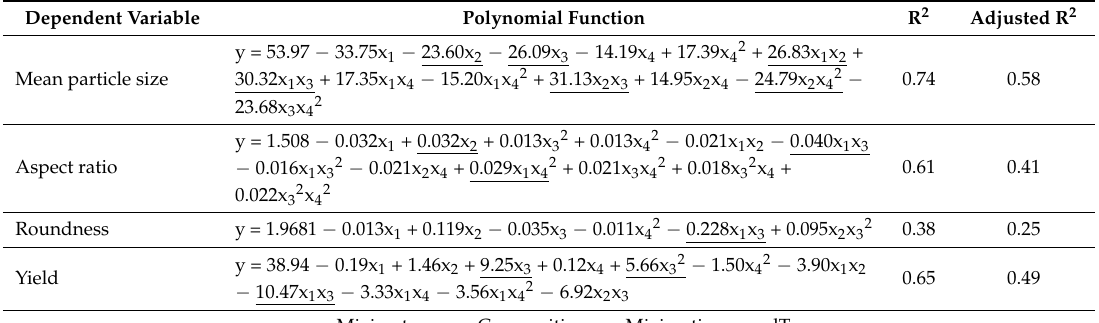
Table 5. Parameters and effects causing significant changes in the dependent variables of the factorial design, applied for the SA method and the polynomial functions describing the conditions of significance.